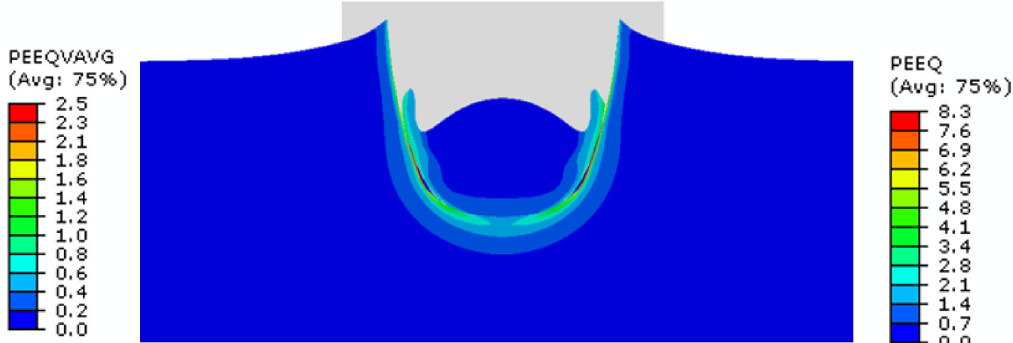
Fig. 10. Evolution of PEEQ and volume average equivalent plastic strain (PEEQVAVG) 500 m/s Cu/Al impact by using the CEL numerical modelling.